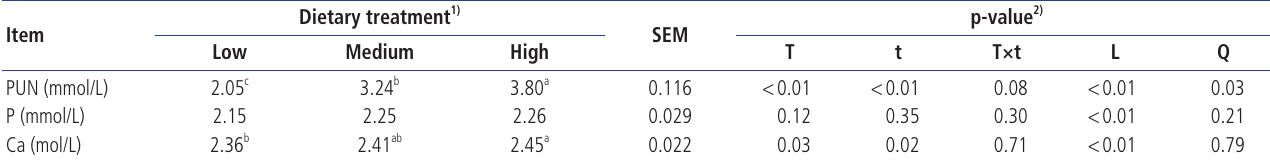
Table 4. Effect of dietary protein level on the plasma urea nitrogen (PUN), calcium (Ca) and phosphorus (P) of heifers Dietary treatment Item